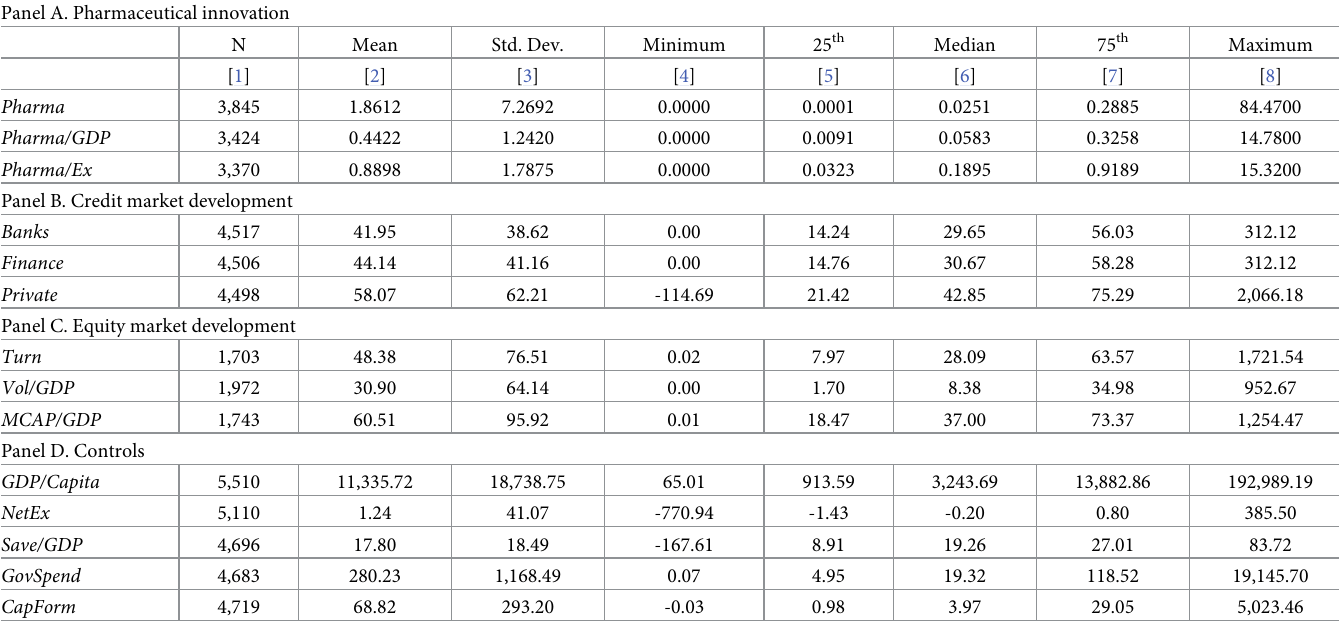
Table 1. Summary